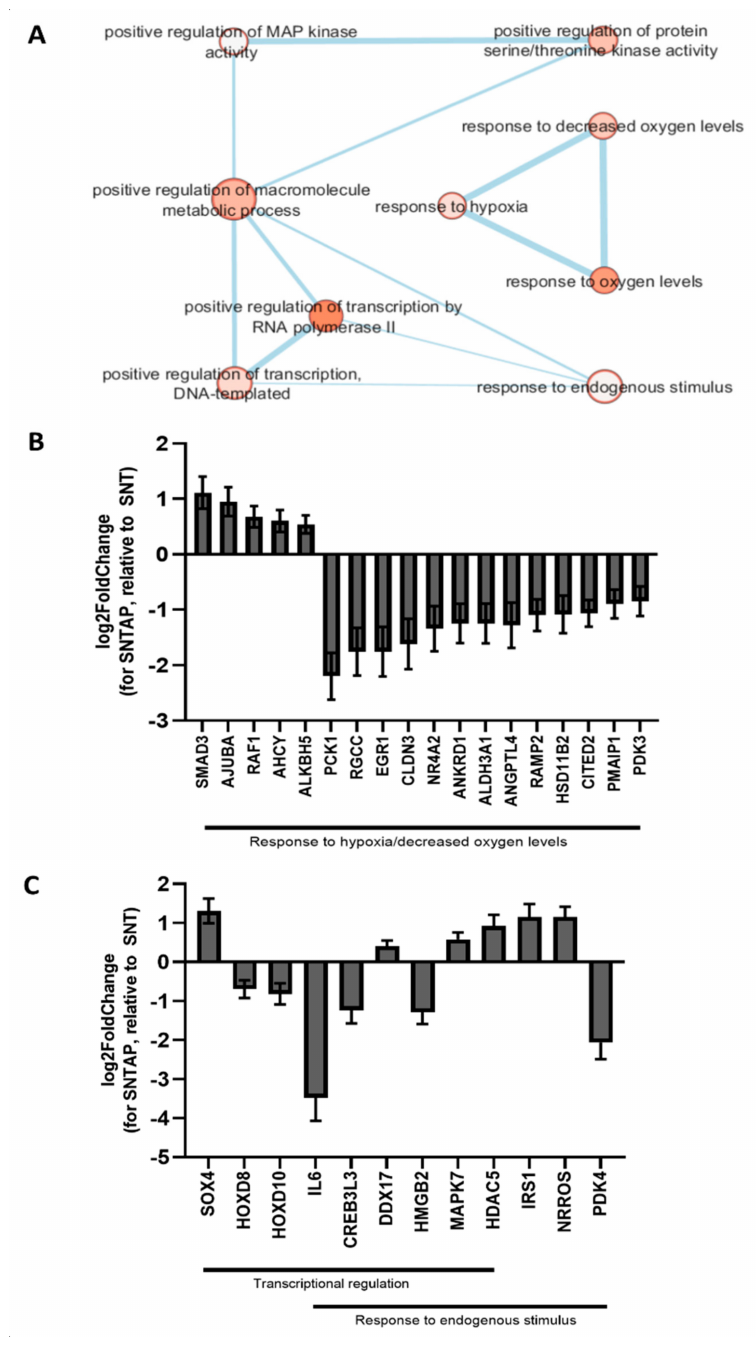
Figure 6. Gene expression analysis after preservation using subnormothermic perfusion with or without AP39. Frozen renal cortical sections ( n = 3 for each group) were used for the RNAseq analysis. Differentially expressed genes were identified using RStudio (DESeq2, alpha = 0.05). GO annotations were found for those genes using g:Profiler, and the network enrichment analysis was performed using Cytoscape. ( A ) Network enrichment map showing certain nodes of interest (FDR Q value < 1.0 and Jaccard Overlap combined coefficient > 0.375 with a combined constant = 0.5). ( B ) Gene expression values (log2 fold change ± SEM, determined using RStudio) of all the genes in the three connected nodes from the enrichment map in ( A )—response to oxygen levels, hypoxia and decreased oxygen levels. ( C ) Gene expression values (log2 fold change ± SEM, determined using RStudio) of certain genes of interest from two nodes of interest from the enrichment map in ( A )—regulation of the DNA-templated transcription and response to the endogenous